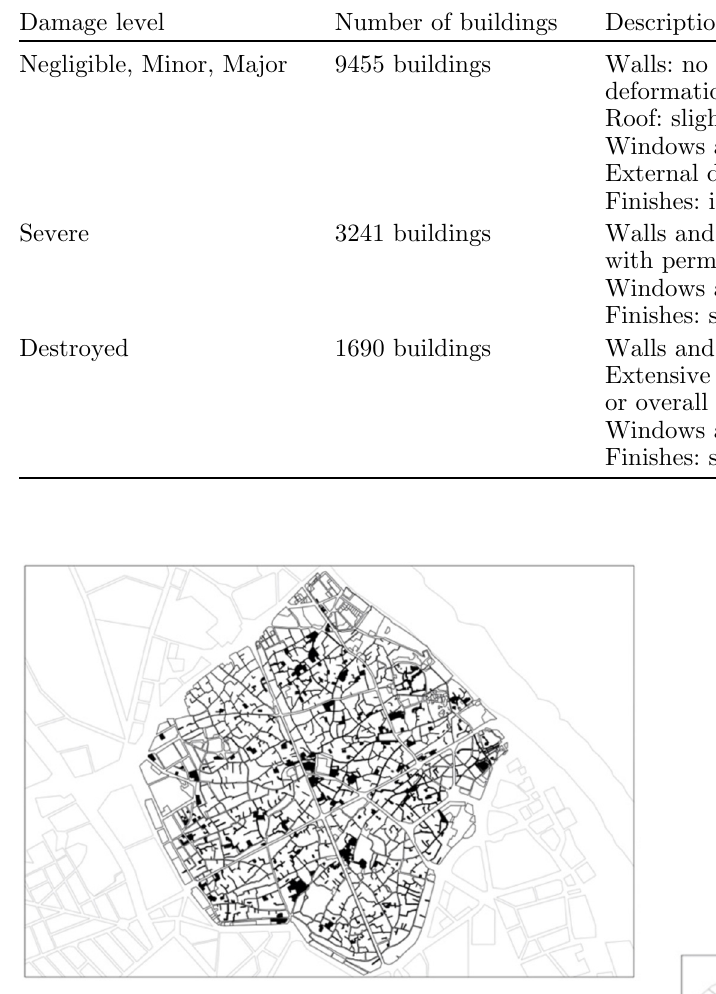
Fig. 5. Intricate small street layout of the Old City.